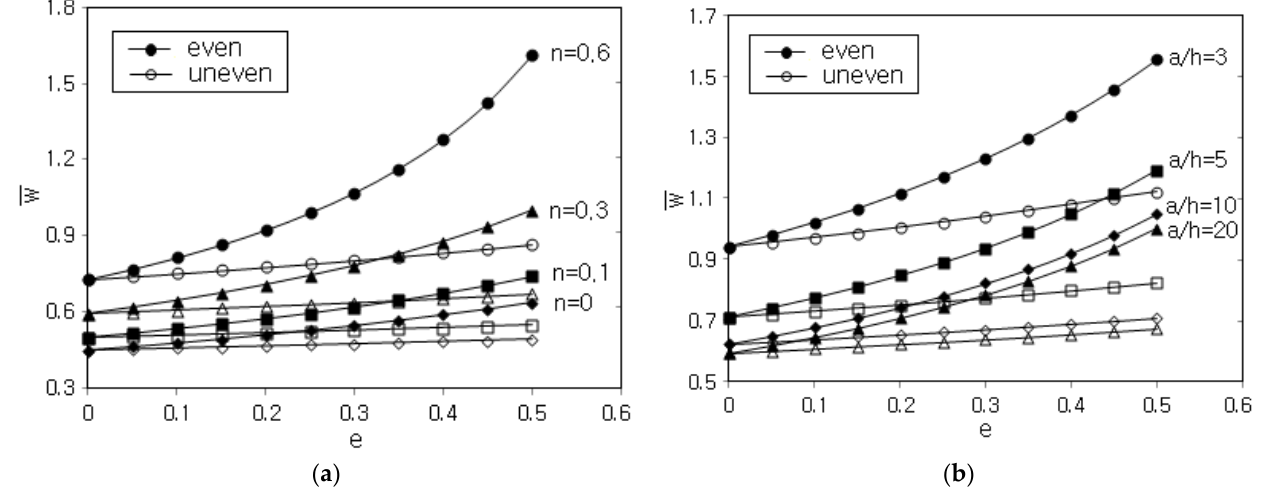
Figure 4. Dependence of the calibrated central deflection on the porosity parameter: ( a ) for different ceramic indices ( a / h = 20 ) , ( b ) for different width–thickness ratios ( n = 0.3 ) .